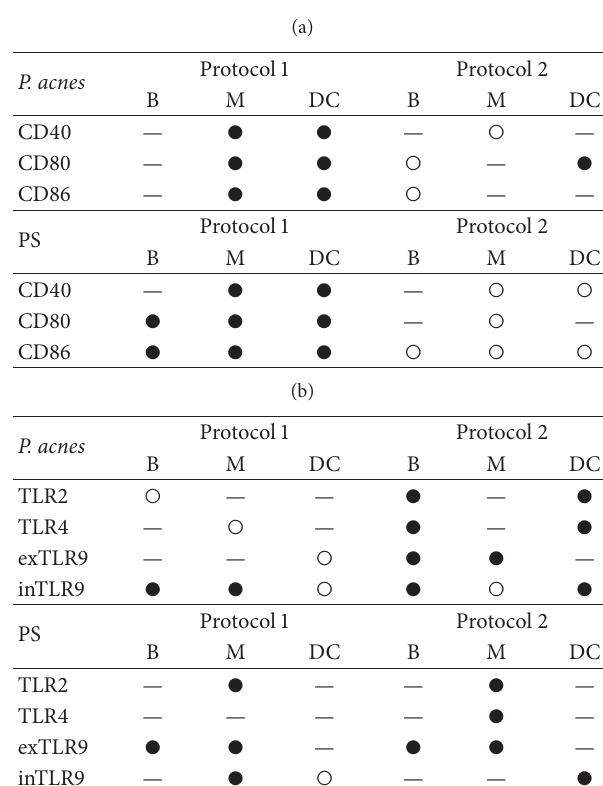
Table 1: Schematic representation of P. acnes and PS effects on co- stimulatory molecules and TLRs expression in Protocols 1 and 2. P . acnes and PS effects on co-stimulatory molecules (a) and TLRs (b) expression in Protocols 1 and 2 are summarized and represented as different symbols. ( e ) indicates up-regulation, while ( I ) indicates down-regulation of each molecule compared to the control